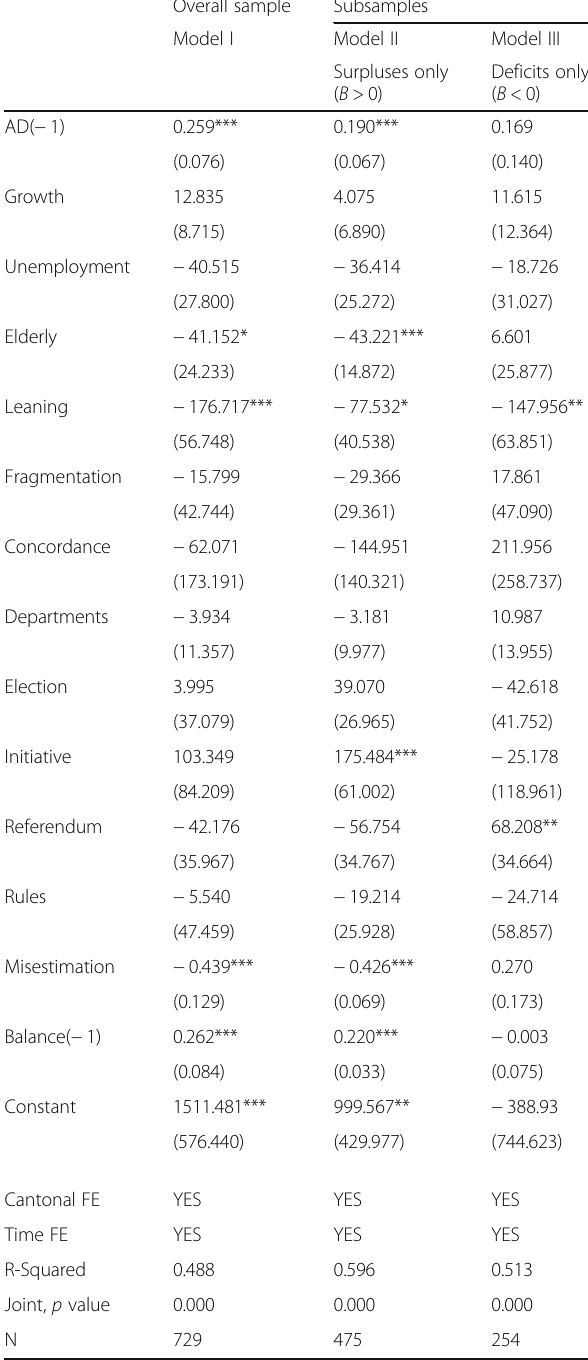
Table 2 Results for the single-equation